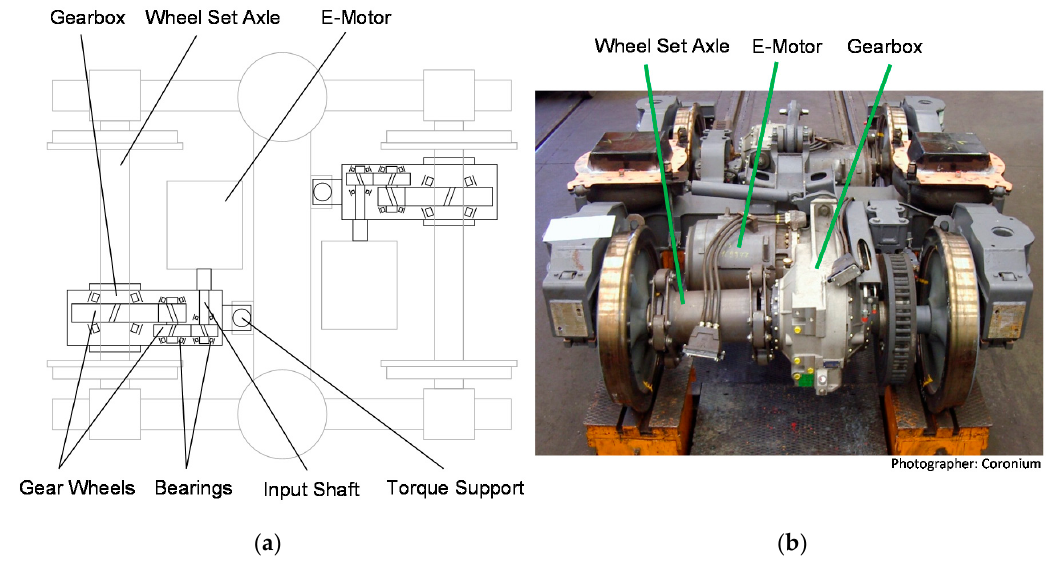
Figure 9. ( a ) Schematic top view of a bogie, main components of railway vehicle gear system; ( b ) picture of a bogie; photographer: Coronium.